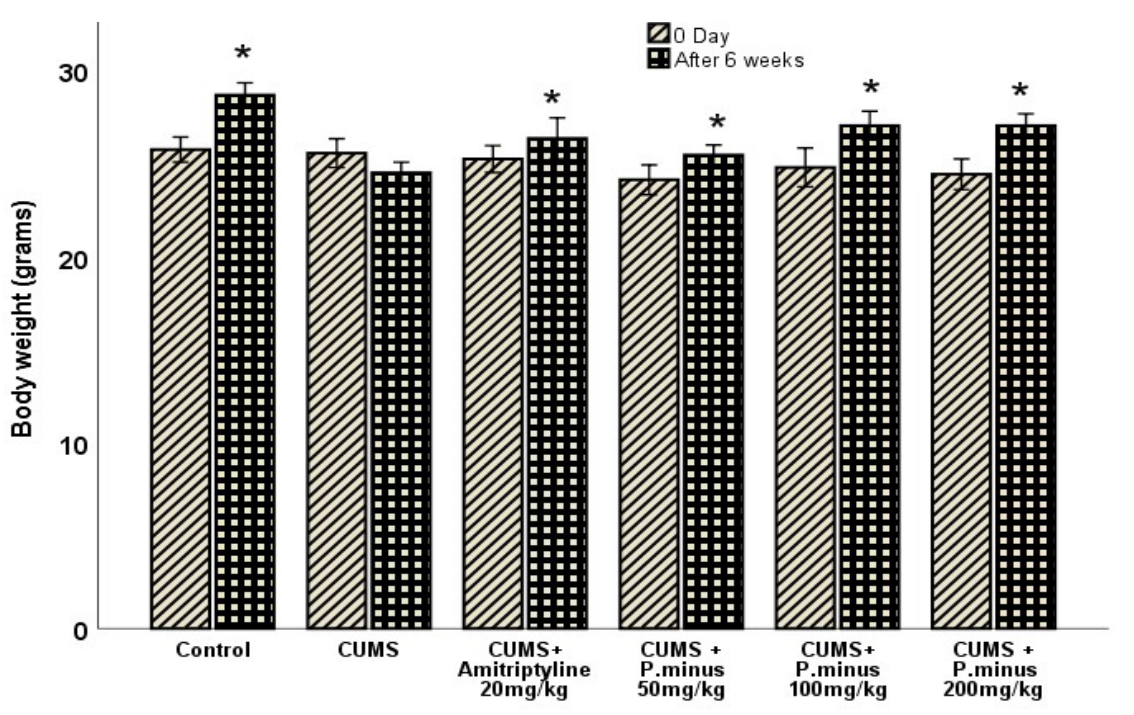
Figure 2. Effects of P. minus aqueous extract on body weight of CUMS induced stressed mice. * ( p < 0.05), vs. zero-day of each group, ( n = 14).